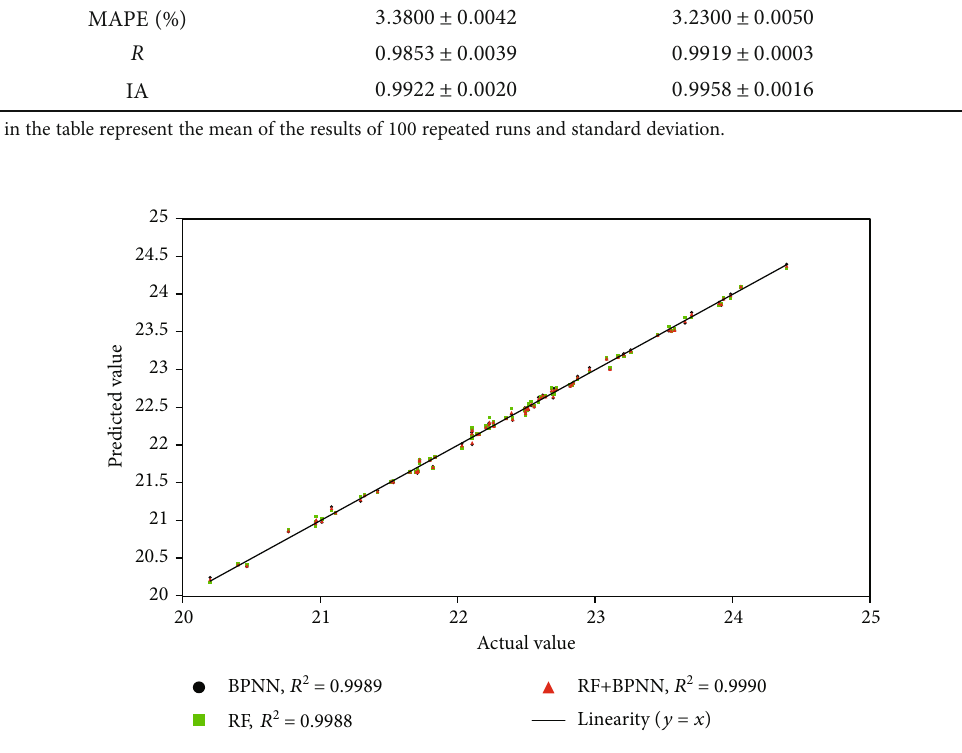
Figure 7: Comparison of HL ’ s true value and predicted